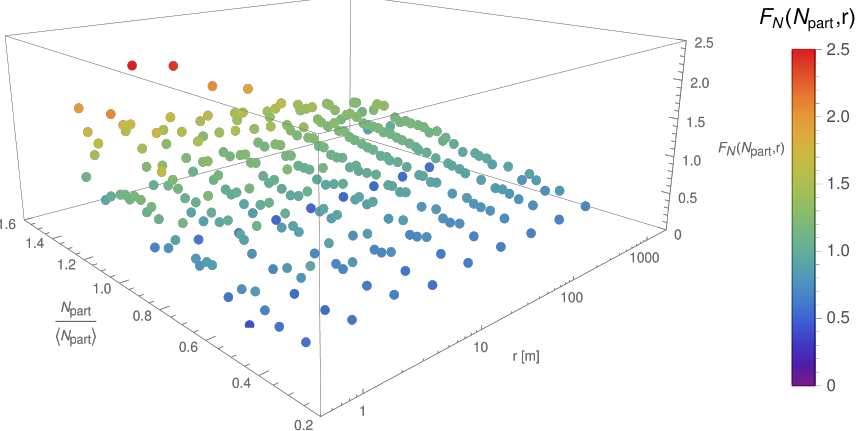
Figure 3. Scaling factor F N ( N part , r ) as a function of the distance r and the ratio of the number of secondary particles reaching the ground and the average number of them for given energy, N part / (cid:104) N part (cid:105) , obtained for vertical cascades initiated by protons with the energy E = 4000